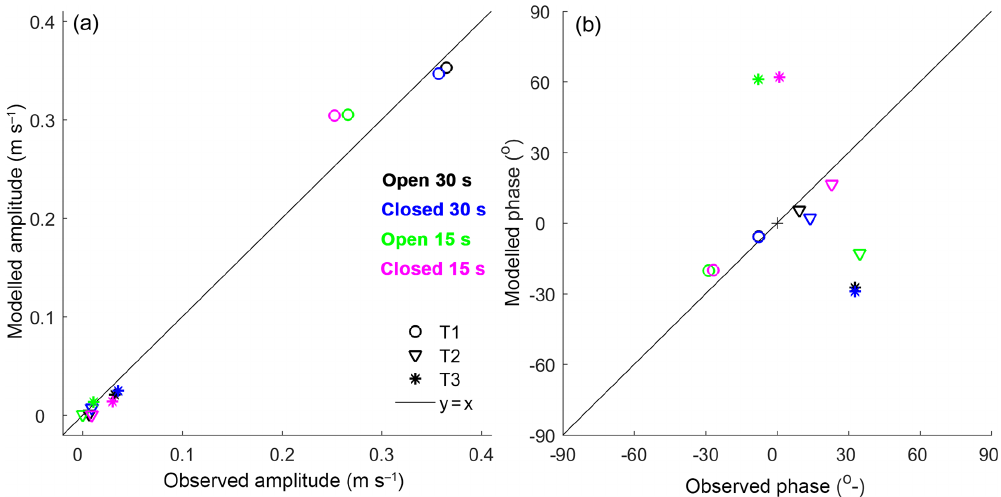
Figure 8. Tidal amplitude (a) and phase (b) in the velocity signal of the model runs compared to the experiments for the tilting flume. The principal tide T1 is the full tidal period of 30 or 15s, and the first overtide T2 and second overtide T3 are the higher harmonics. Dashed lines indicate the perfect fit plus or minus an error of 0.01ms − 1 to indicate the uncertainty range of the